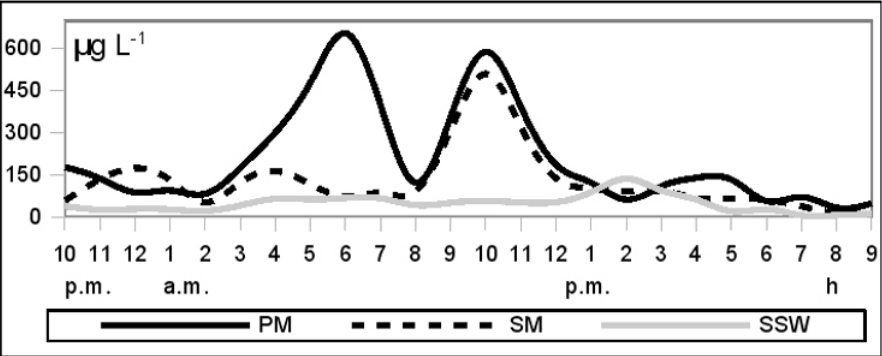
Figure 3. Diurnal variation in the concentration of organic phosphorus (µg L -1 ) in surface microlayers and subsurface water of Lake Dołgie Wielkie.